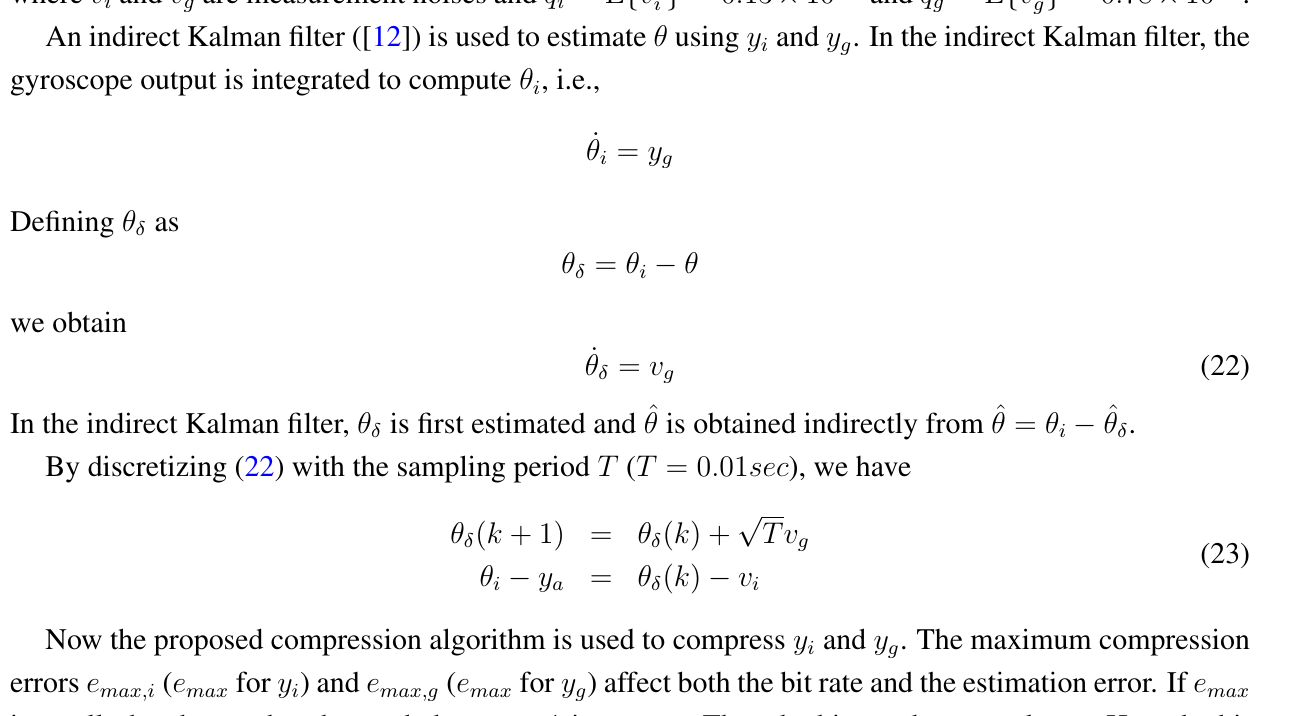
Figure 4. Relationship between e